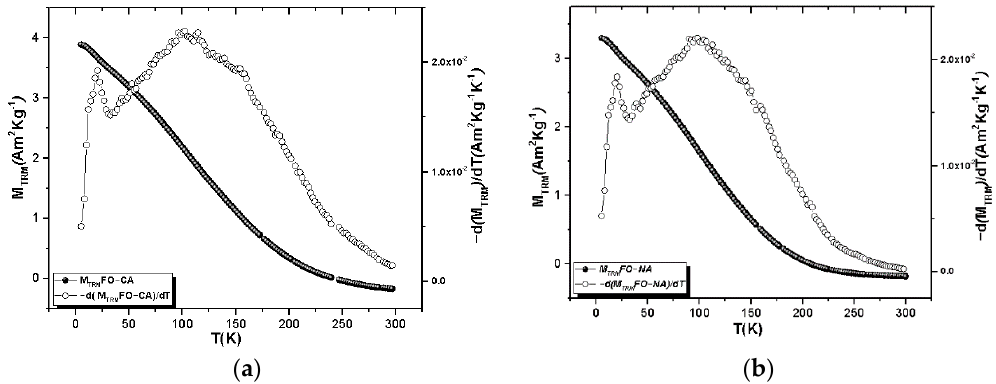
Figure 5. M TRM curve (full circles), measured after cooling at 2.5 mT and anisotropy energy barrier distribution (empty circles) for ( a ) FO − CA and ( b ) FO − NA samples. Table 3 . Temperature Corresponding to the Maximum in ZFC Curve (T max ), Irreversibility Temper- ature (T irr ), and Blocking Temperature (T B − TRM ) From TRM measurement and the blocking temper- ature from Hansen and Mørup approach (T B . H . M ) for FO − CA and FO − NA samples, uncertainties on the last digit are given in parentheses.